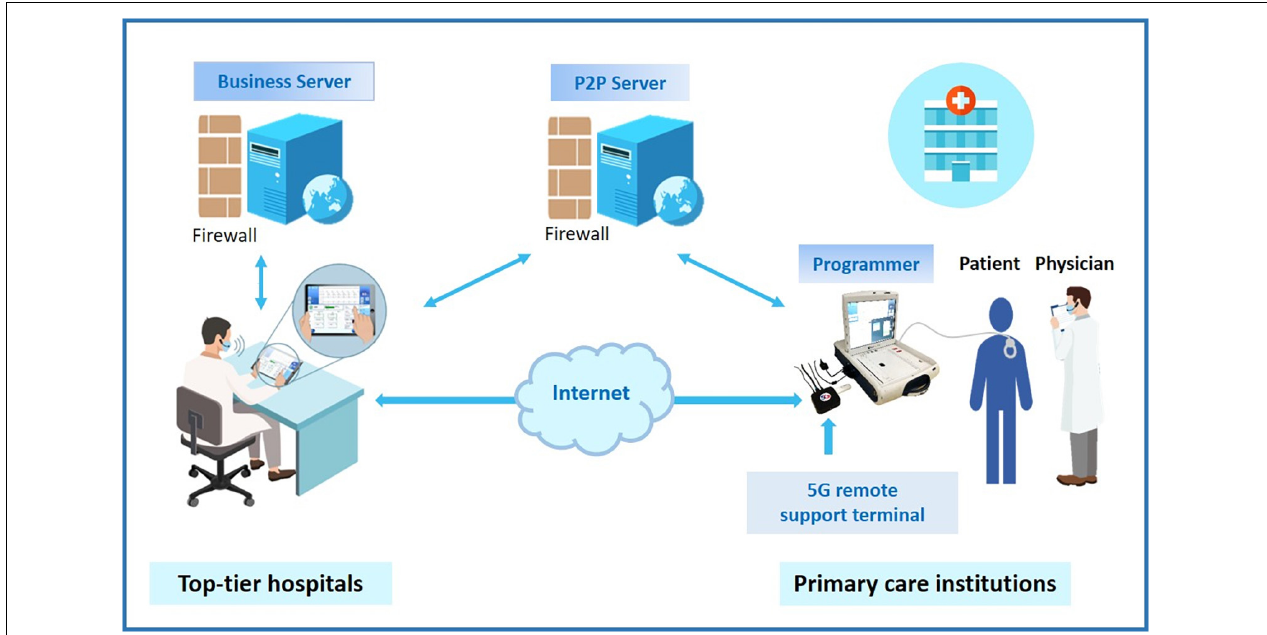
FIGURE 1 | The schematic of application of 5G-cloud follow-up. Top-tier hospitals provide cloud follow-up services for primary care institutions in areas lacking follow-up clinics. By addressing the limitations of an imbalanced distribution of follow-up clinics and geographic barriers, cloud follow-up makes in-office visits more accessible for CIED patients living in remote areas. Moreover, cloud follow-up is particularly convenient for patients with a great need for urgent device programming. CIED, cardiovascular implantable electronic